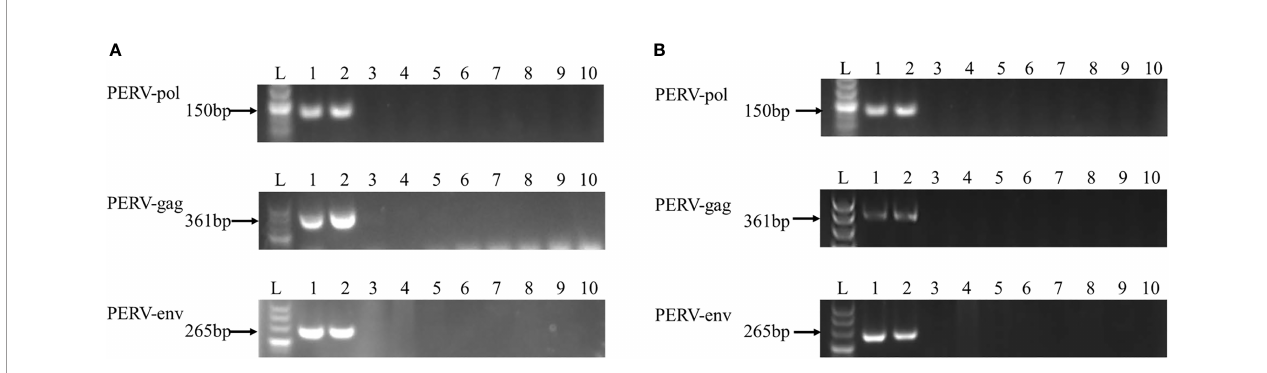
FIGURE 1 | PCR (A) and RT-PCR (B) analysis of PERV elements. Agarose gel electrophoresis was performed with PERV-pol, PERV-gag, and PERV-env PCR and RT-PCR products obtained from DNA (A) and RNA (B) prepared from HEK293 cells cocultured with the PBMC derived from the following WZSPs: lane 2, WZSP153 (a transmitting WZSP, as a positive control); lane 3-9, WZSP169, WZSP456, WZSP444, WZSP129, WZSP1213, WZSP505, WZSP452. Lane 1, positive control (PK15 cells); lane 10, no template control (NTC). The sizes of the products obtained are indicated to the